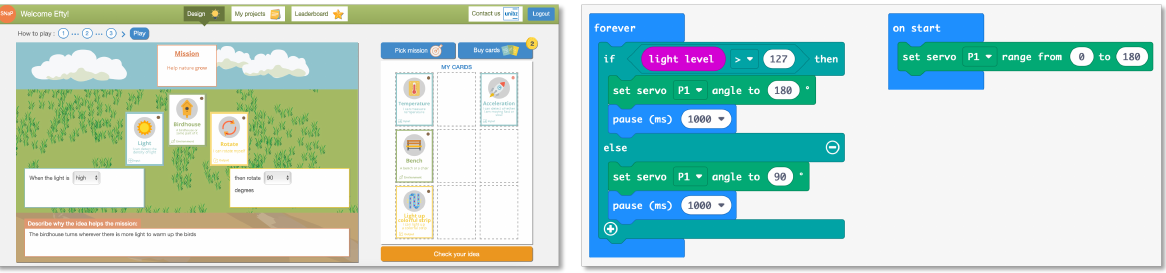
Figure 6. The environment of digital SNaP ( left ) and a SNaP-generated code for MakeCode ( right ). Design Stages &